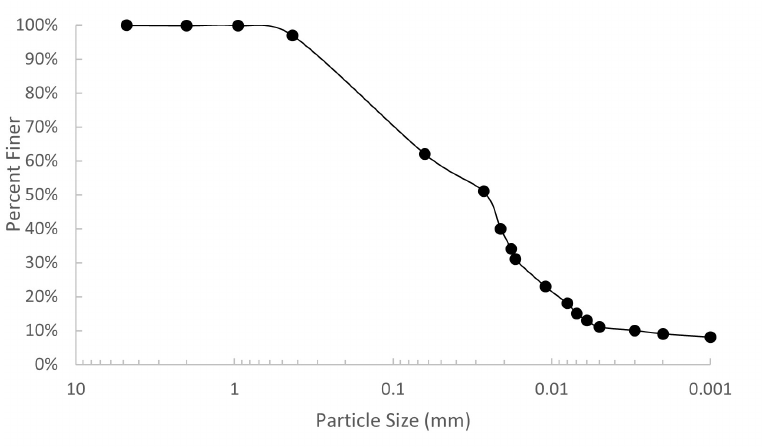
Figure 7. Sediment size